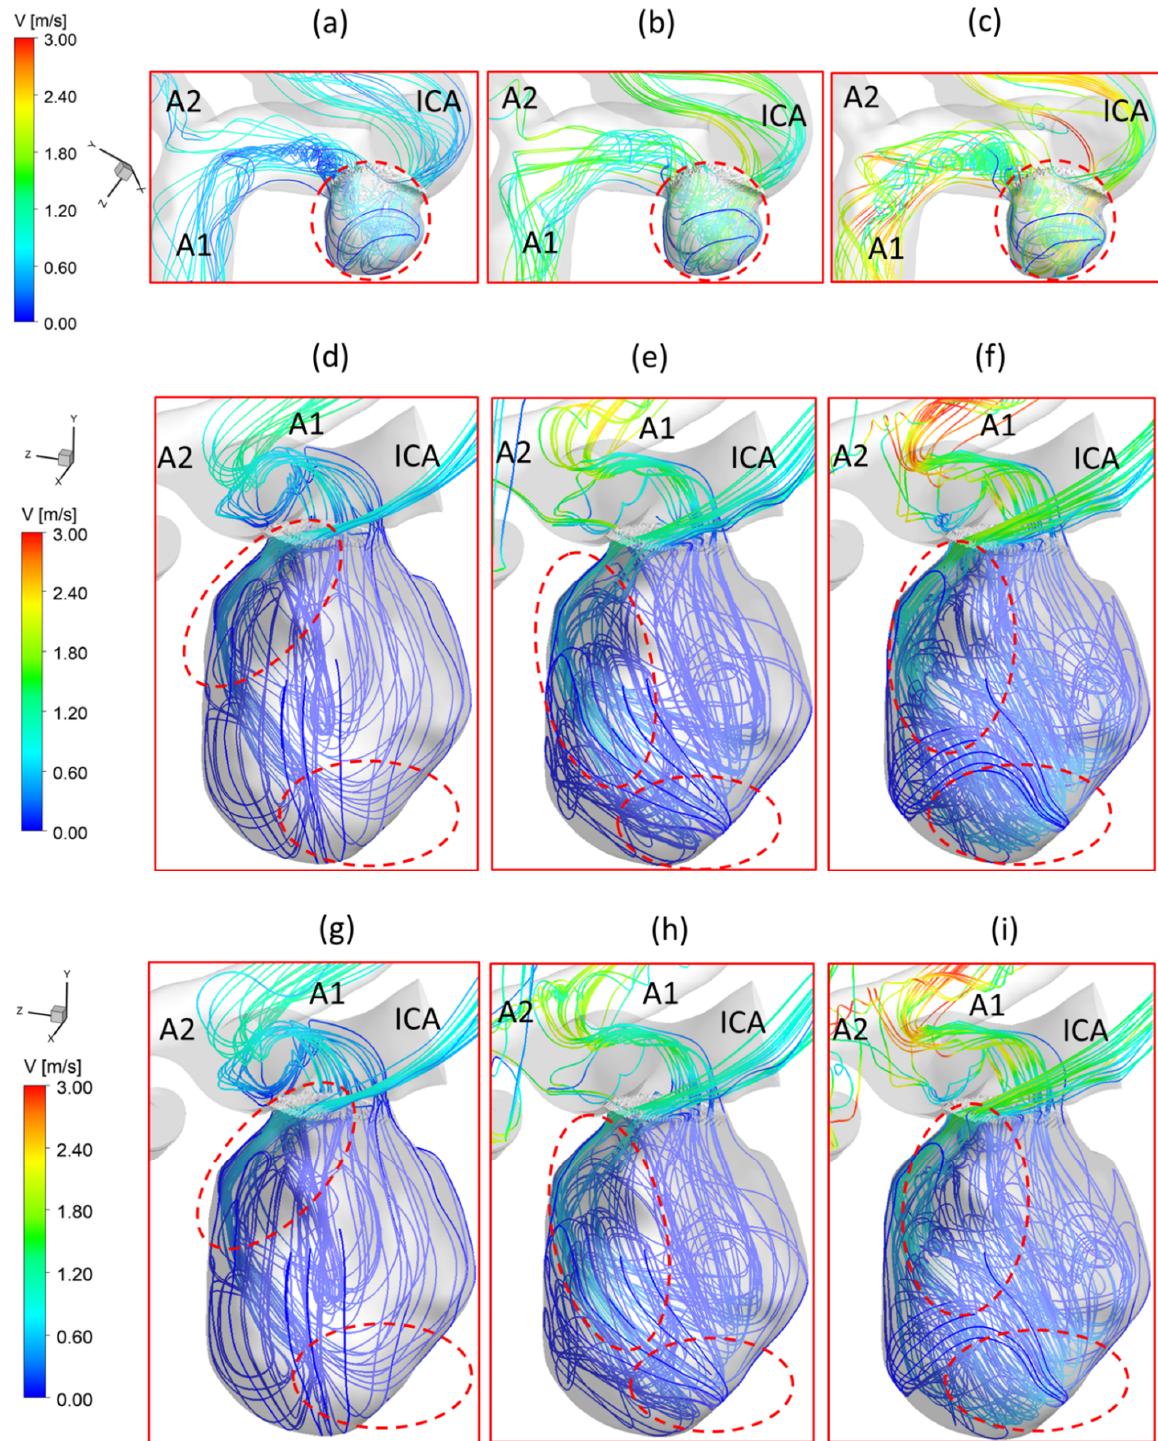
Figure 7. Visualized flow streamlines in ICASA−1 (S1) and ICASA−2 (S2) models under different conditions at t 2 = 0.13 s: ( a ) ICASA−1, q A1 :q A2 = 75:25, and PFR−I, ( b ) ICASA−1, q A1 :q A2 = 75:25, and PFR−II, ( c ) ICASA−1, q A1 :q A2 = 75:25, and PFR−III, ( d ) ICASA−2, q A1 :q A2 = 75:25, and PFR−I, ( e ) ICASA−2, q A1 :q A2 = 75:25, and PFR−II, ( f ) ICASA−2, q A1 :q A2 = 75:25, and PFR−III, ( g ) ICASA−2, q A1 :q A2 = 64:36, and PFR−I, ( h ) ICASA−2, q A1 :q A2 = 64:36, and PFR−II, and ( i ) ICASA−2, q A1 :q A2 = 64:36, and PFR−III.